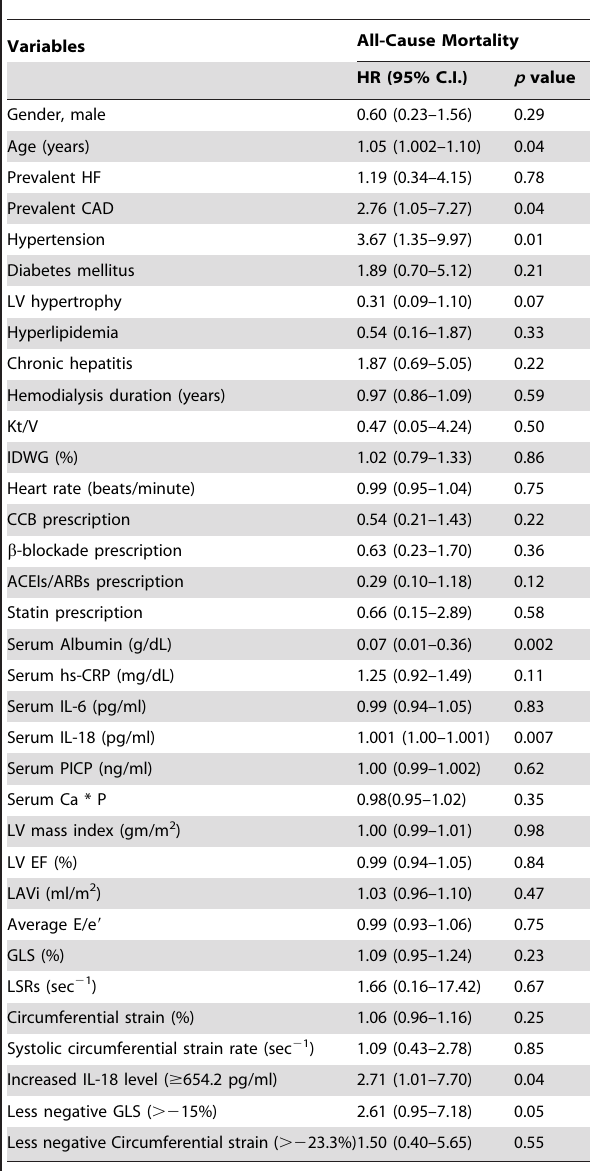
Table 4. Univariate Cox regression analysis of factors in relation to all-cause